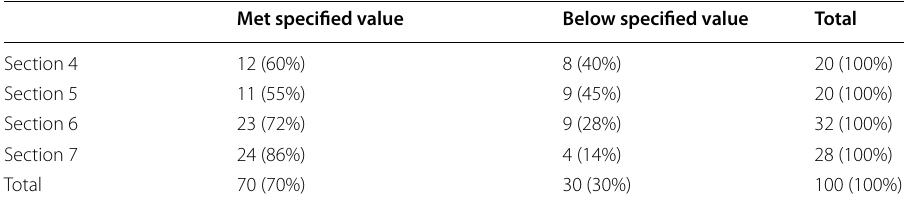
Table 5 The extent to which the 100 items meet the specified discrimination index (based on point-biserial correlations) for the entire test per test section